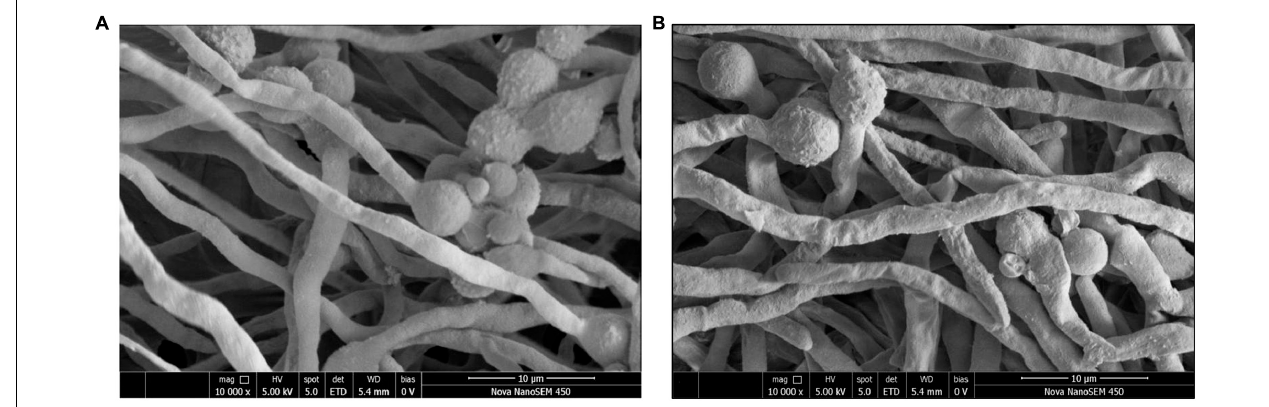
FIGURE 3 | Morphology of A. flavus spores inoculated in PDB medium with the E. cristatum culture filtrate (B) and water (A) .